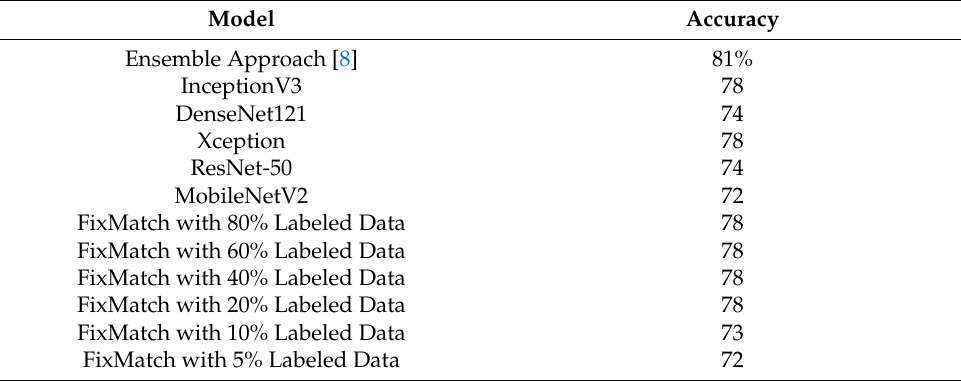
Table 9. Accuracies across the various